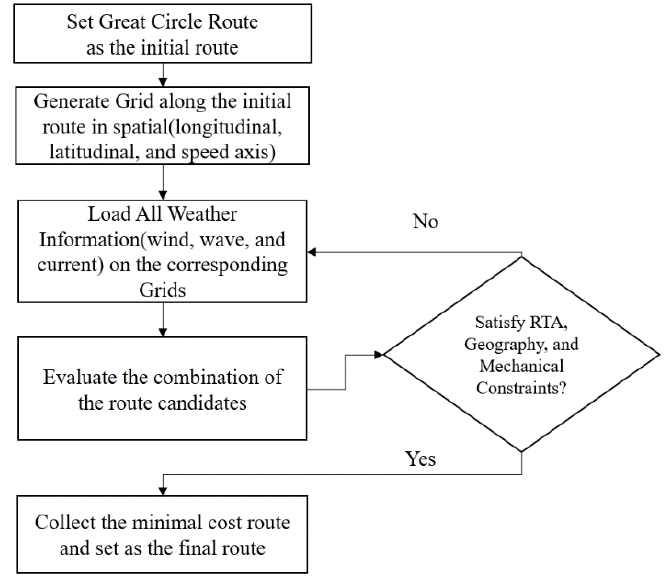
Figure 7. Conventional state of the art (3DDP) routing algorithm.